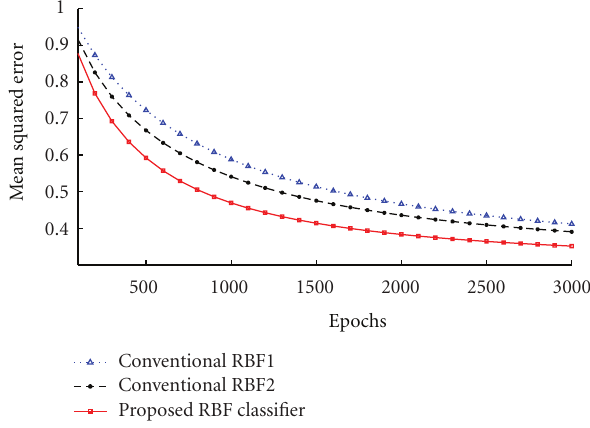
Figure 4: Error convergence on RBF